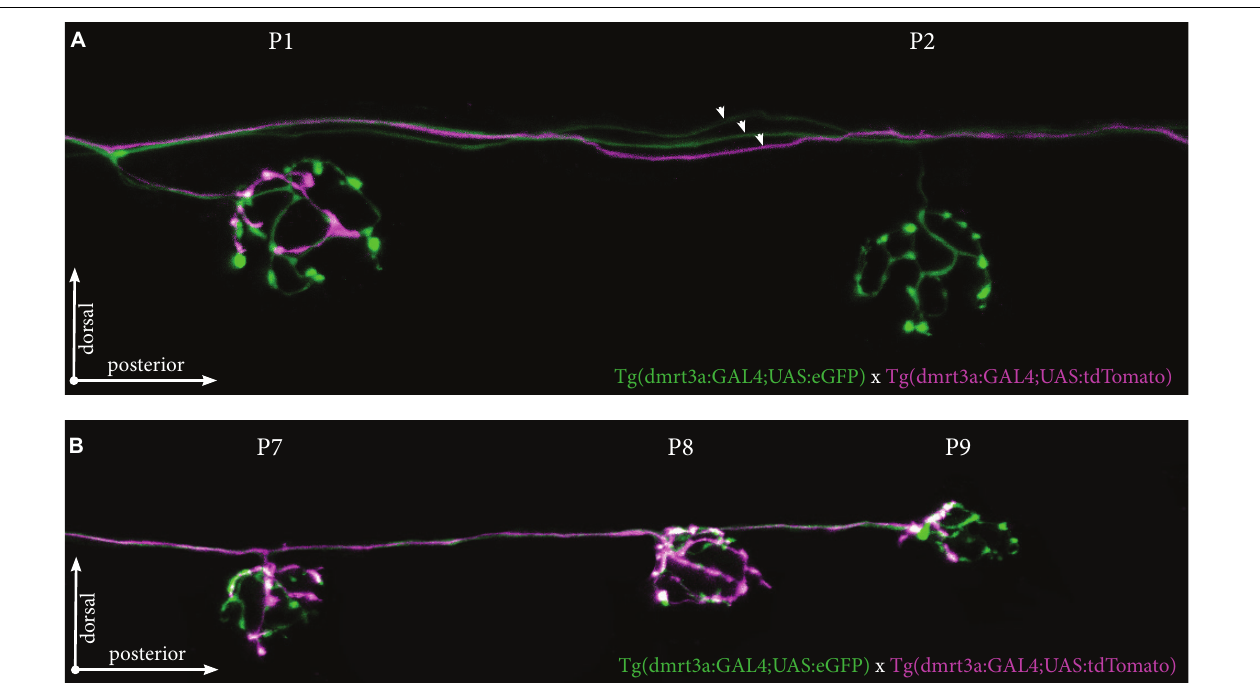
FIGURE 7 | Tg( dmrt3a :GAL4;UAS:tdTomato) crossed with Tg( dmrt3a :GAL4;UAS:eGFP) reveal multiple inhibitory efferent processes innervating a single neuromast. (A) Confocal images of neuromast P1 and P2 of the PLL. All efferent projections were labeled by Tg(dmrt3a:GAL4;UAS:eGFP) (green) and single efferent projection was labeled by Tg(dmrt3a:GAL4;UAS:tdTomato) (magenta). Note how the single tdTomato-positive (magenta) projection connects to the P1 neuromast, but skips the P2 neuromast. Arrowheads indicate three different efferent projections along the PLL. (B) In the same larvae as in (A) , the single tdTomato-positive (magenta) projection connects to the last three neuromasts of the PLL (P7-P9). Age of larvae: 5